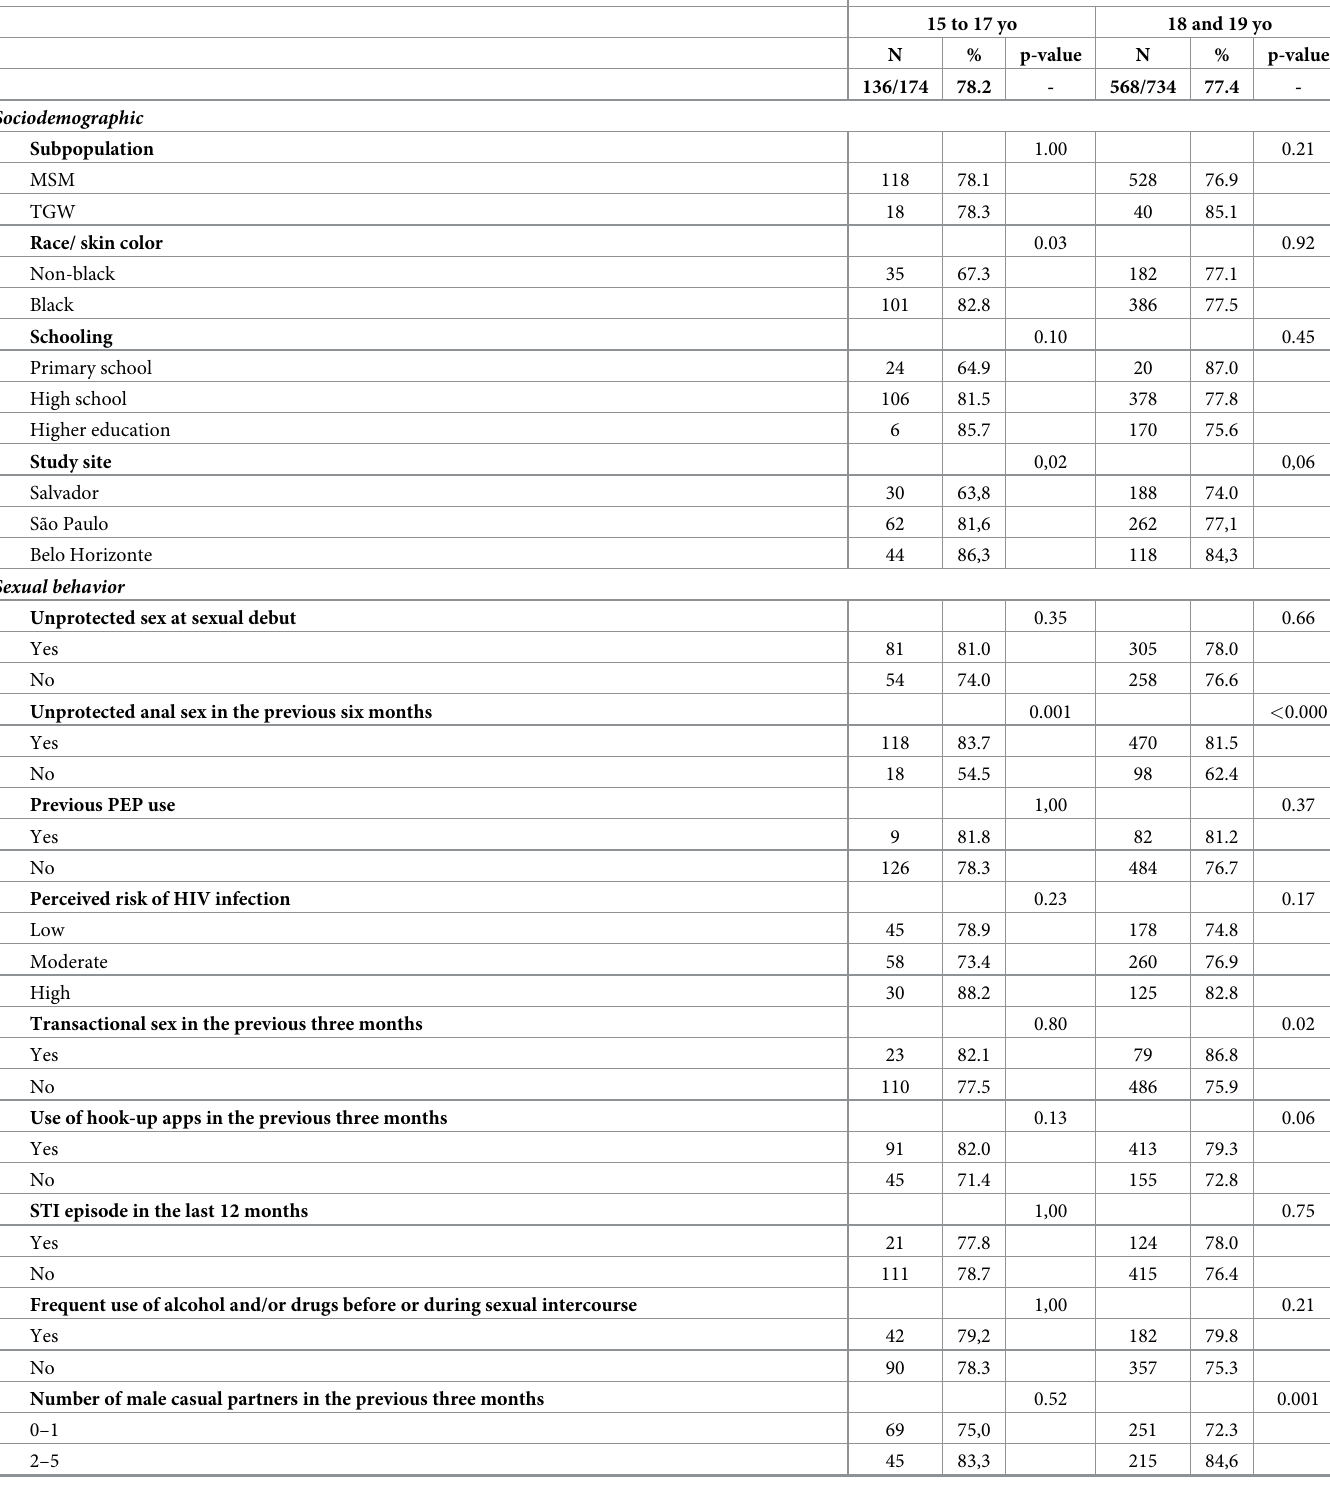
Table 2. Bivariate analysis of PrEP initiation among adolescent MSM and TGW enrolled in the PrEP1519 cohort by age group. February 2019—February 2021.